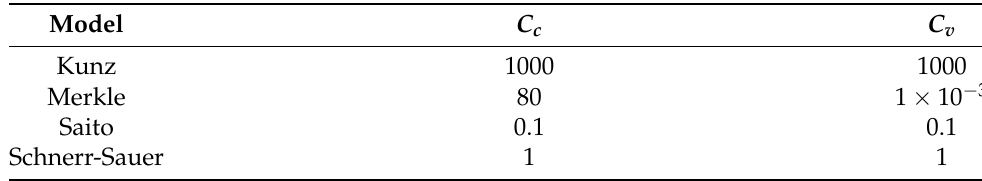
Table 2. Standard